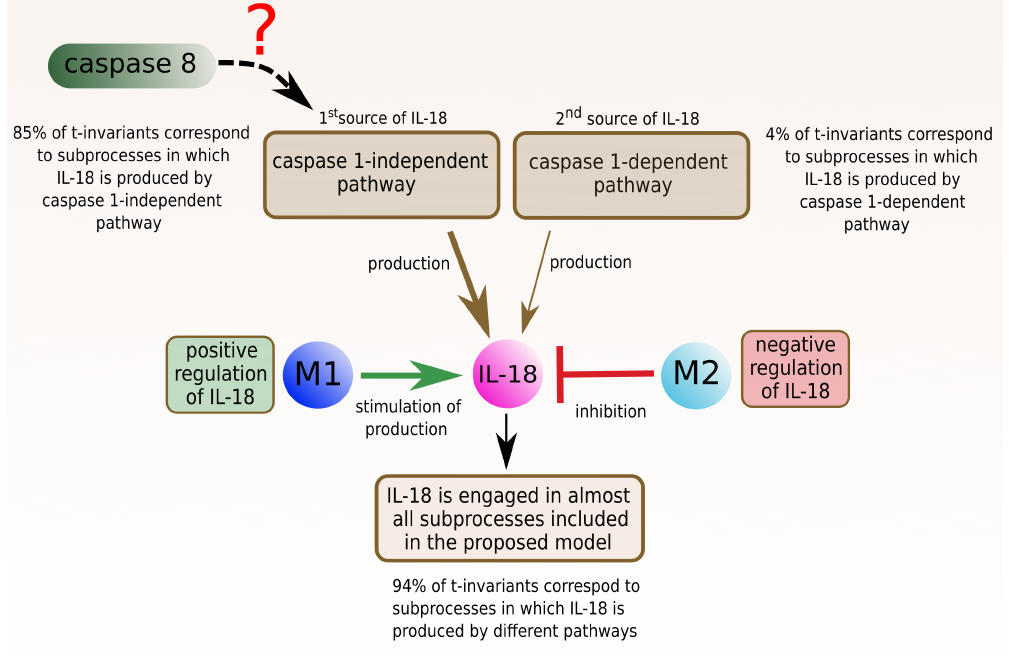
Figure 7. The influence of different types of macrophages on IL-18. The results suggest that caspase 1-independent pathway may be associated with caspase 8